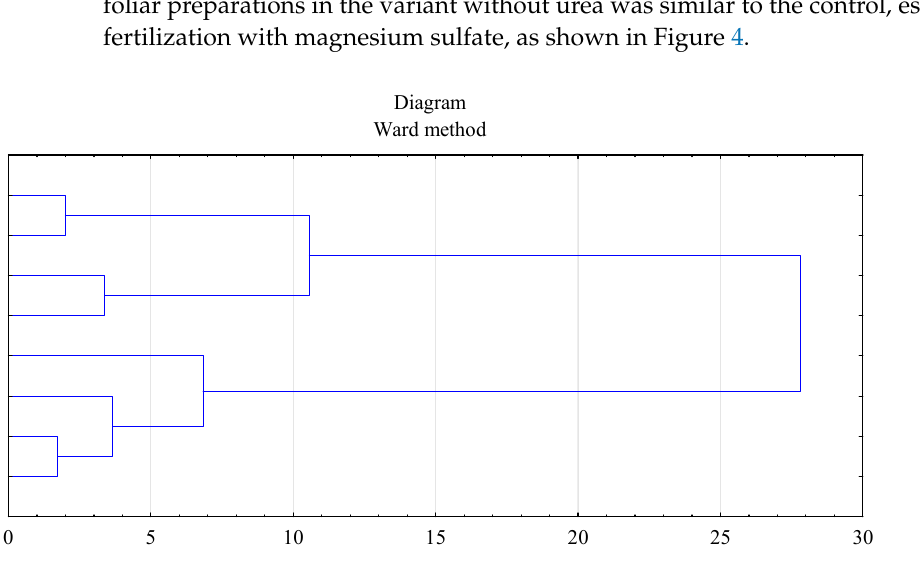
Figure 4. Dendrogram of foliar fertilization variants. Description in Table 1. It was shown that the SPAD index was strongly positively correlated with the num- ber of siliquae per plant and fat yield. Seed yield was strongly positively correlated with the number of siliquae per plant, TSW, fat, and protein yield. On the other hand, TSW was strongly positively correlated with protein and fat yield, as shown in Table 6.